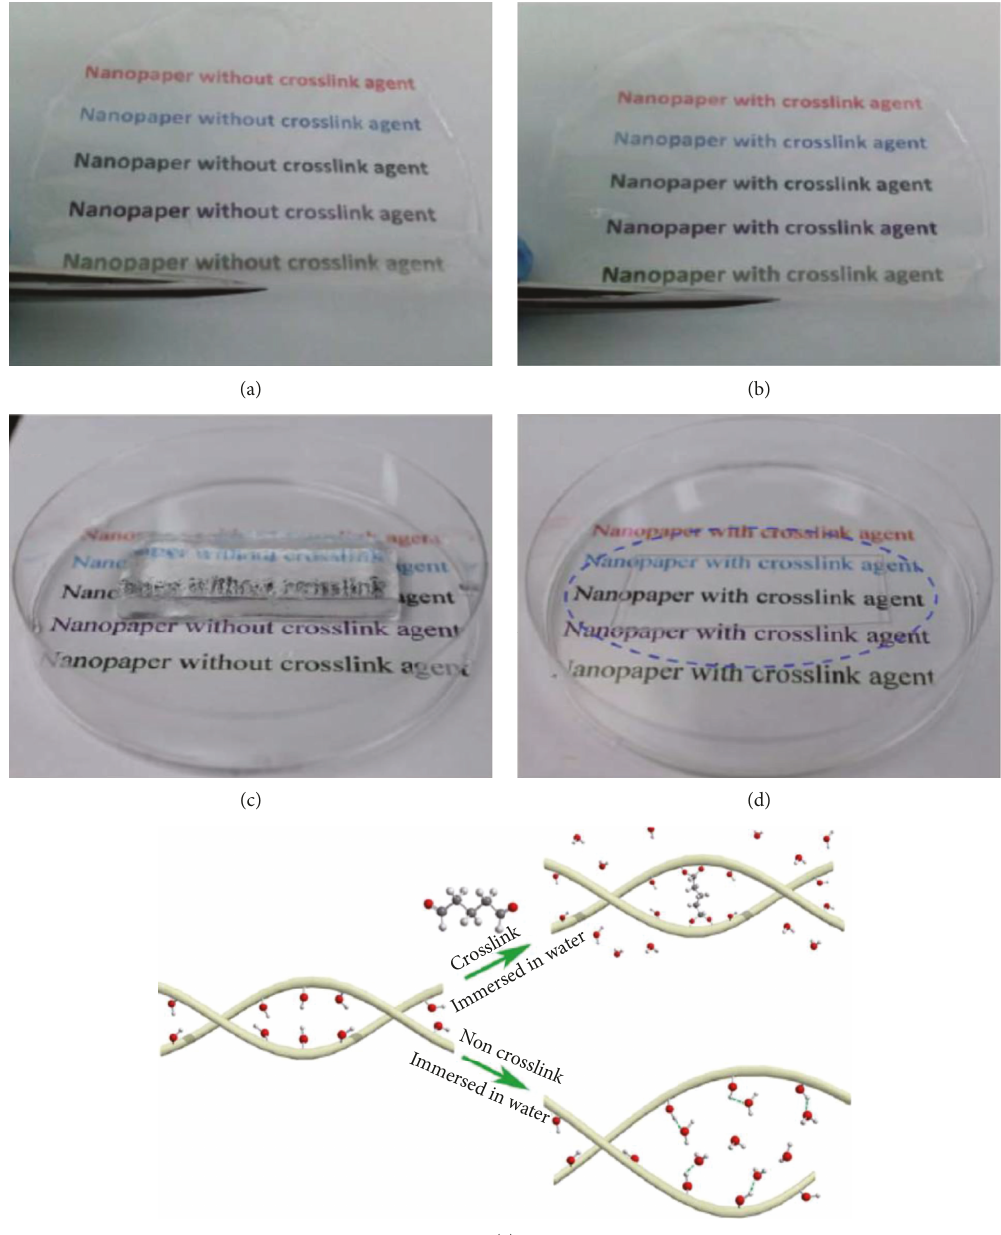
Figure 12: (a) Pristine nanopaper before the cross-linking treatment. (b) Nanopaper after the cross-linking treatment. (c) Pristine nanopaper after immersion in water for 24h. The thickness of the nanopaper expanded from 30 μ m to 6mm. (d) Cross-linked nanopaper immersed in water for 24h. (e) Schematic representation of the shape stability improvement attained after glutaraldehyde treatment. Reproduced from reference [48] with permission from the Royal Society of